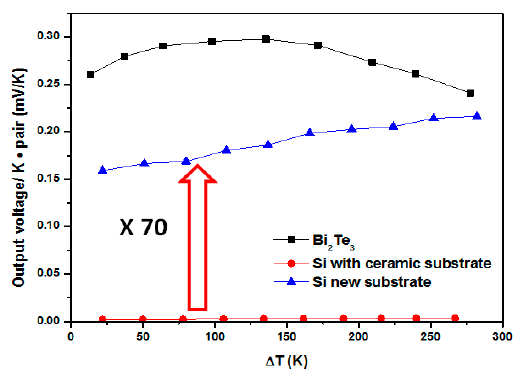
Figure 5. Output measurement results of the commercial Bi 2 Te 3 thermoelectric module, the commercial thermoelectric module using a ceramic substrate, and the optimized silicon thermoelectric module.